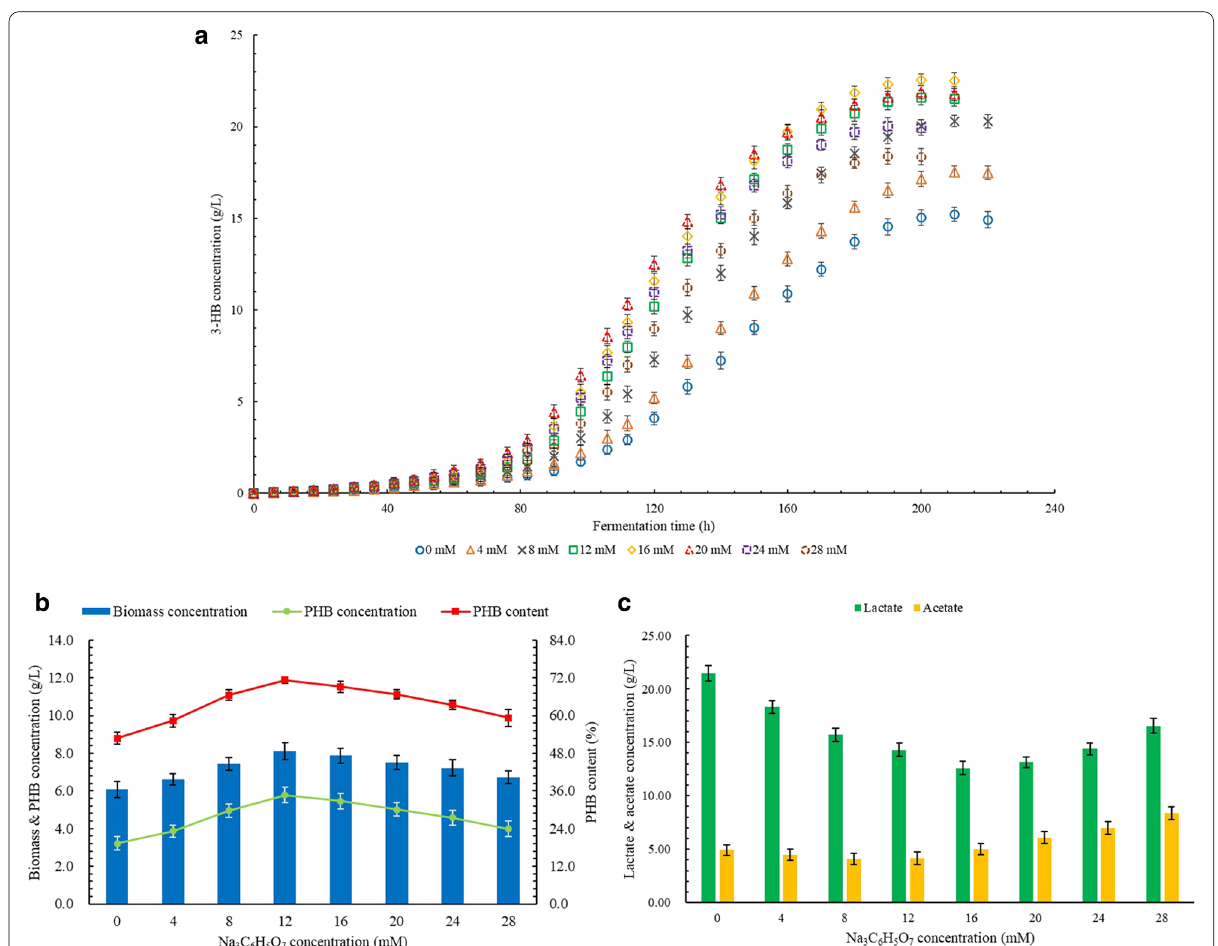
Fig. 4 a Effects of Na3C6H5O7 on the production of 3-HB. b Effects of Na3C6H5O7 on the production of PHB. c Effects of Na3C6H5O7 on the production of LA and AC